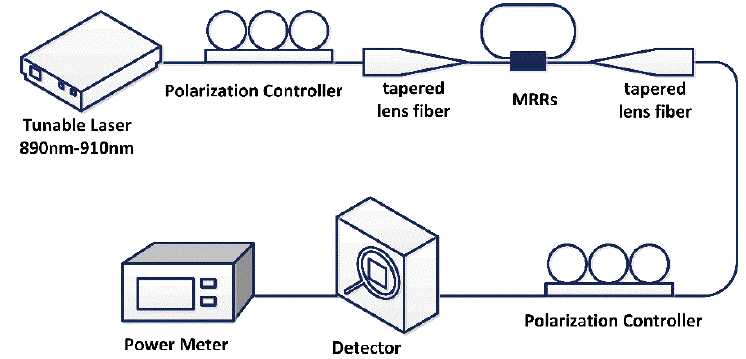
Figure 8. The schematic of the measurement setup.